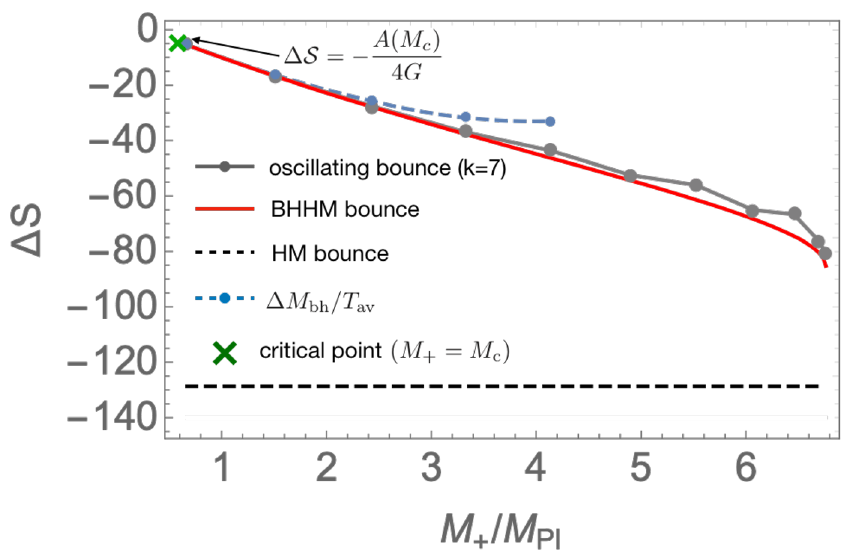
Figure 10 . Plot of the entropy change for the oscillating bounce with k = 7 (grey), BHHM bounce (red) and HM bounce (black dashed), and (cid:1) M bh =T av (blue). The critical point ( M + = M c ’ 0 : 59 M Pl ) is marked with the green cross and the Nariai limit is at M + ’ 6 : 7 M Pl in our setup. We set (cid:12) =